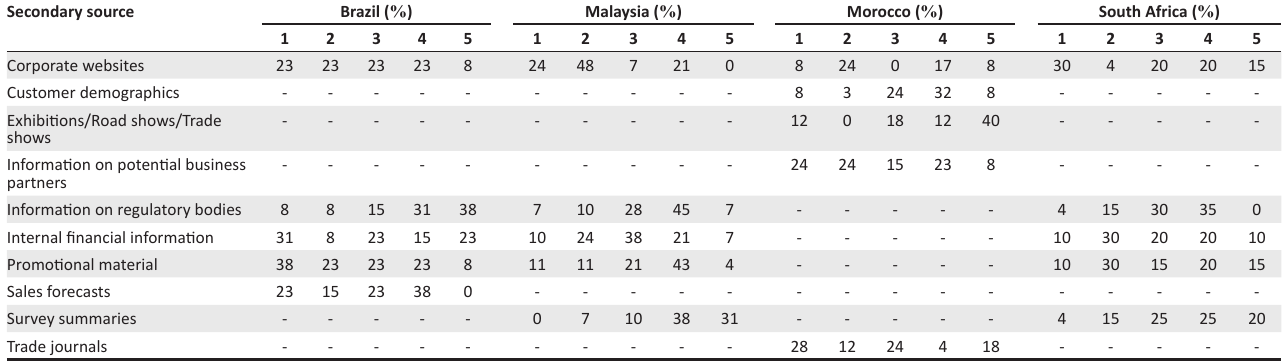
TABLE 1: The five most important secondary sources used by the respondents in this study. Secondary source